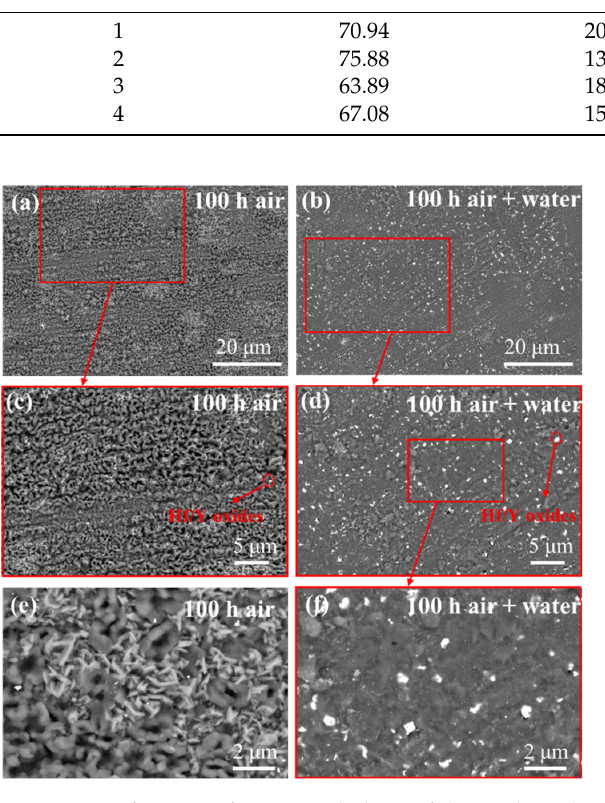
Figure 2. Surface SEM/BSE morphology of the oxide scale on NiCrAlYHf alloy after oxidation at 1100 °C for 100 h in air ( a , c , e ) and air–water vapor ( b , d , f ).